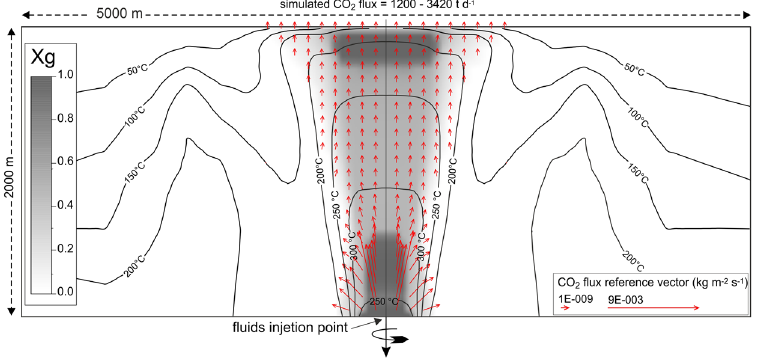
Figure 2. Computational domain of TOUGH2 simulations. The temperature, the volumetric gas fraction Xg (different shades of grey) and the CO 2 flux vectors refer to initial steady-state conditions. Details of the modelling are reported in ref.